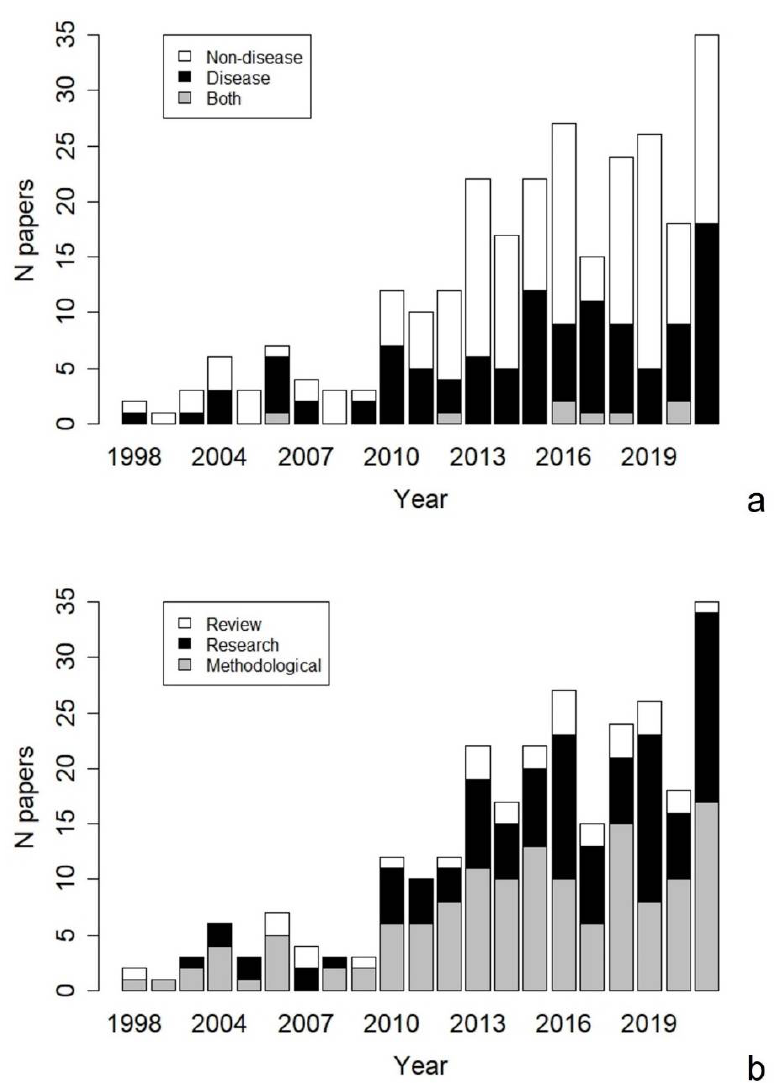
Figure 1. The number of articles on non-invasive sampling in wildlife published from 1998 to 2021 divided by general topic ( a ) and type ( b ). For a definition of categories, see Table 1 .